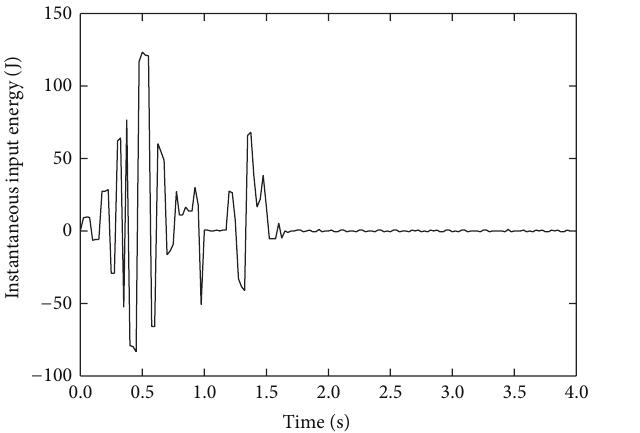
Figure 5: Time history of instantaneous input energy.